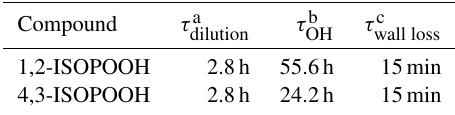
τ b τ c dilution OH wall loss